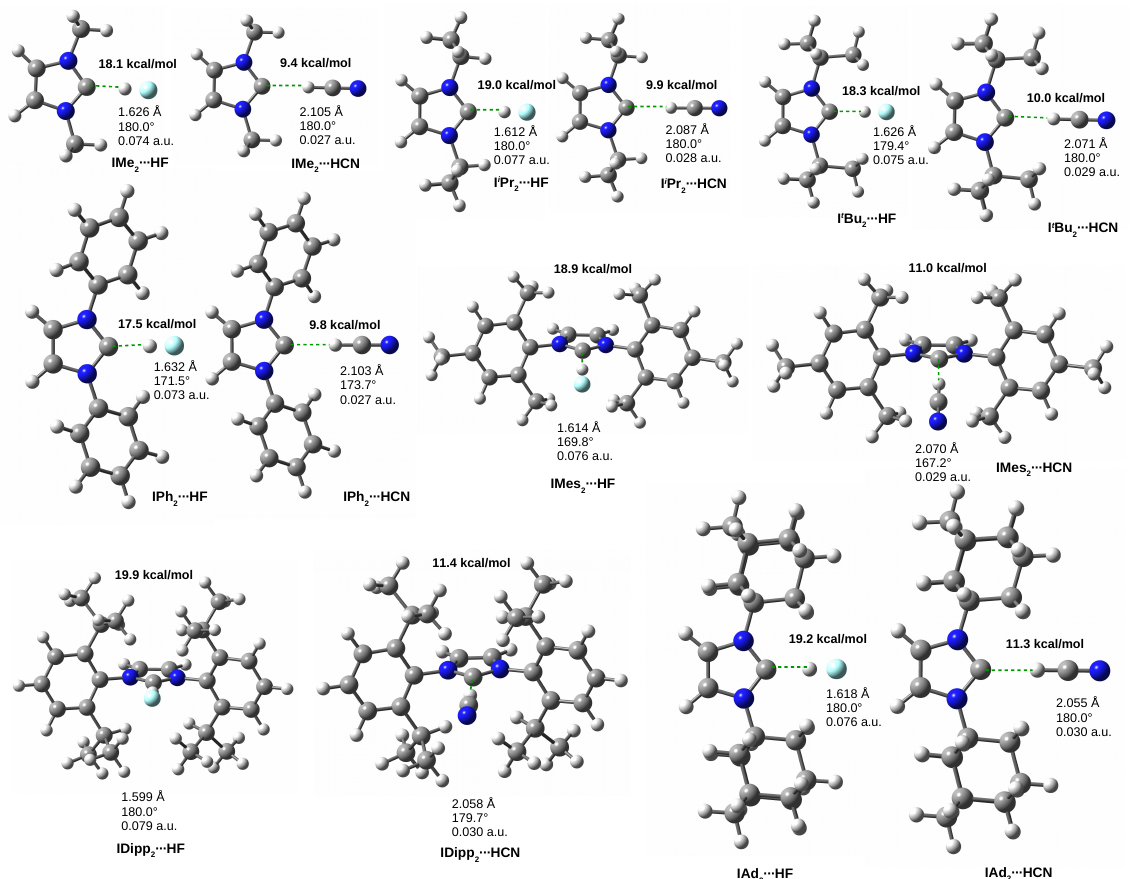
Figure 5. The IR 2 · · · HF and IR 2 · · · HCN (R = Me, i Pr, t Bu, Ph, Mes, Dipp, Ad) dimers. The values of the dissociation energy are given in bold, while the three values refer to the length of the hydrogen bond, the C-H-D angle and the value of the electron density at the bond critical point of the C · · · H-D hydrogen